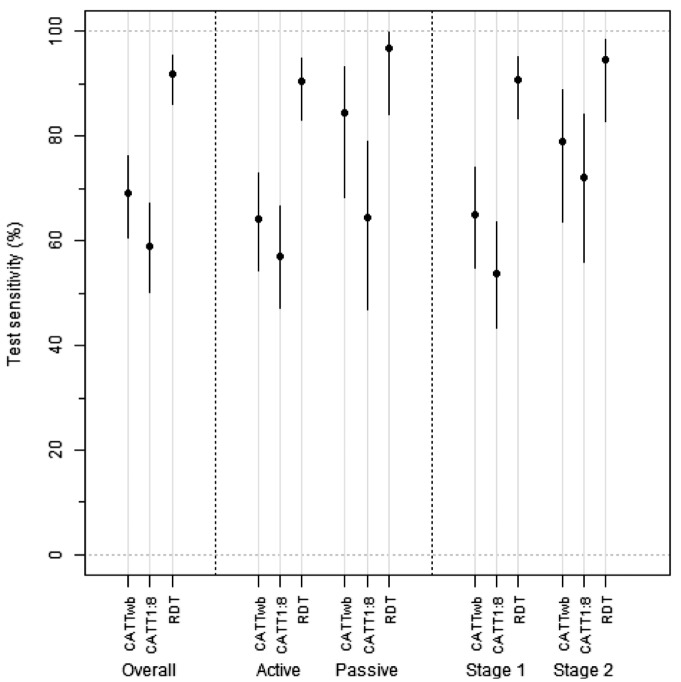
Sensitivity of the tests.Points represent the estimates and lines the 95% CIs. Active and passive refer to active and passive screening.